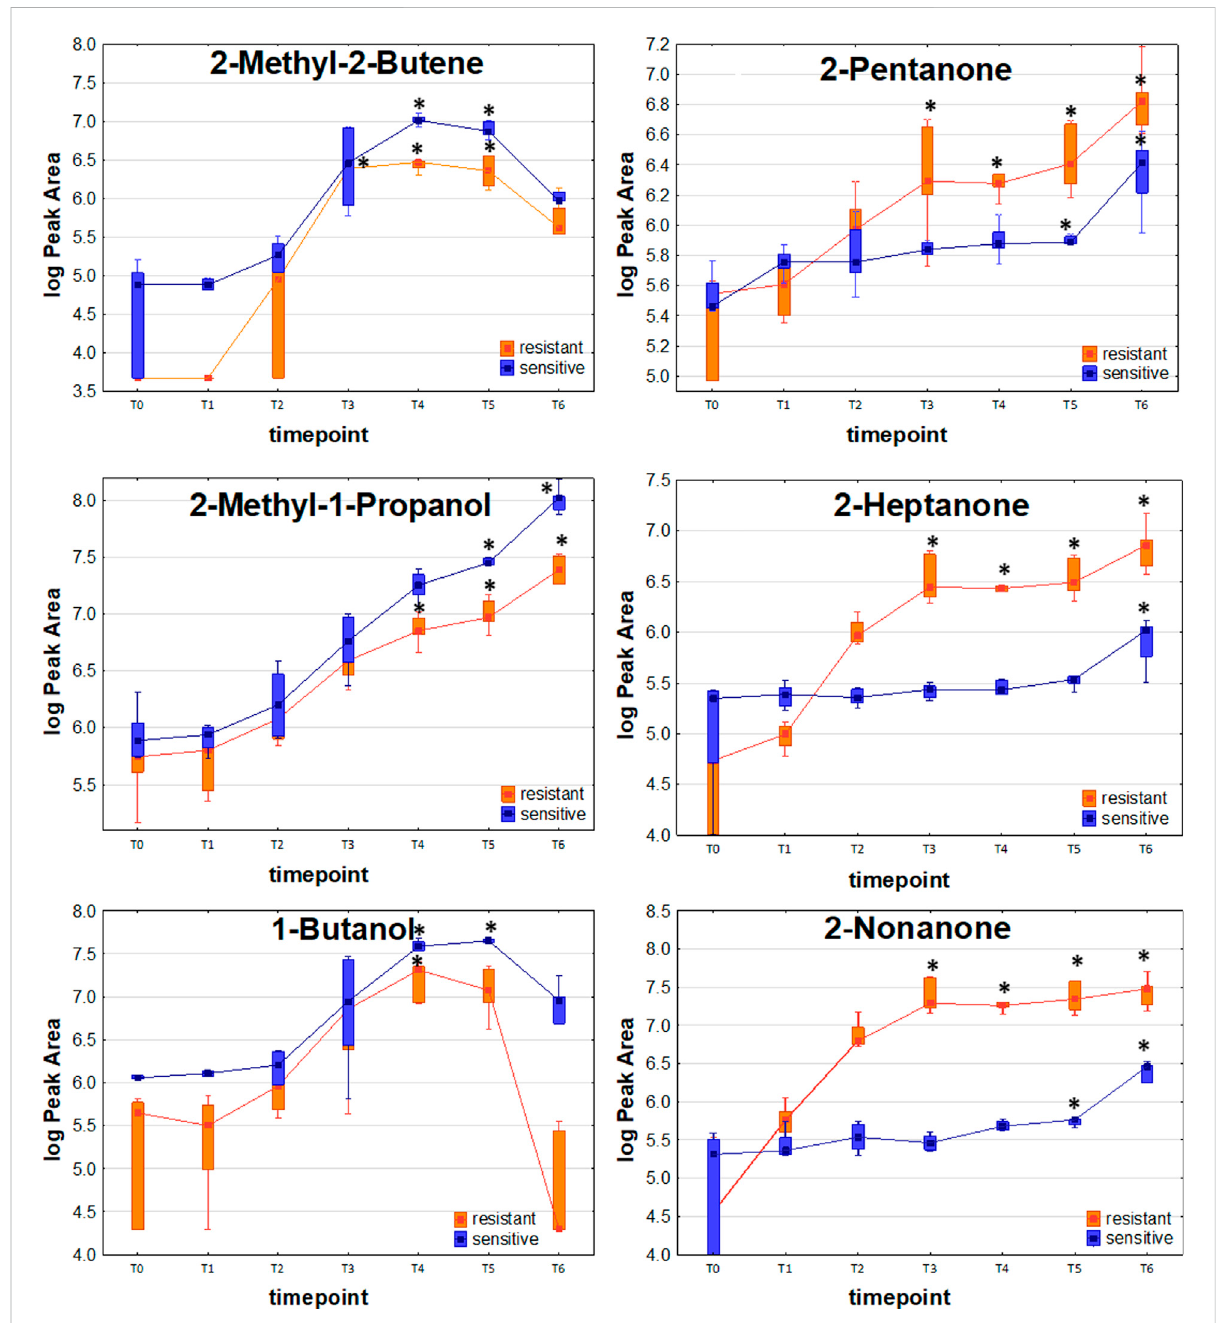
FIGURE 4 Comparison of exemplary VOC pro fi les released by sensitive and resistant strains of Klebsiella pneumonia